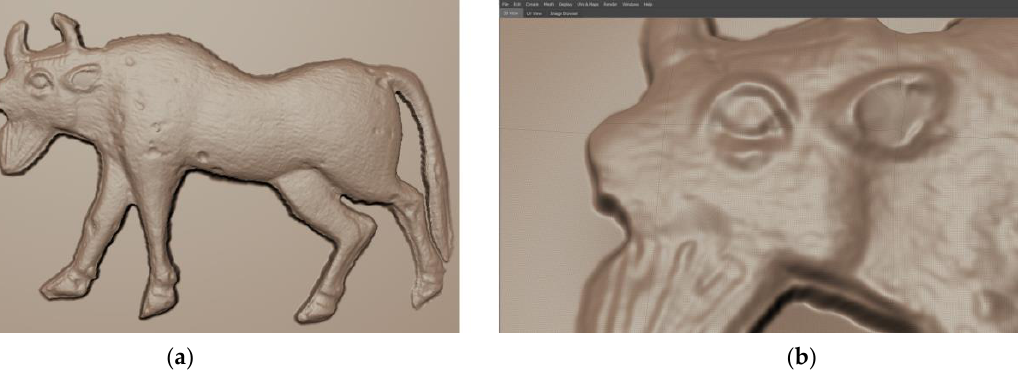
Figure 10. ( a ) The result of the reconstruction of the aurochs’ ornament as a whole; ( b ) Close-up view of the aurochs’ head .